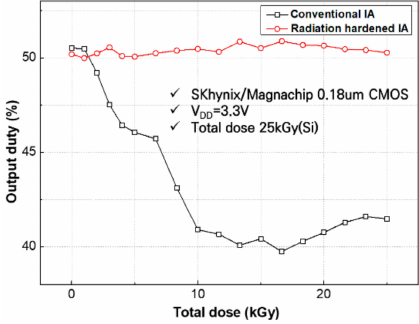
Figure 12. Change in the duty ratio of the IA with respect to the increasing total cumulative